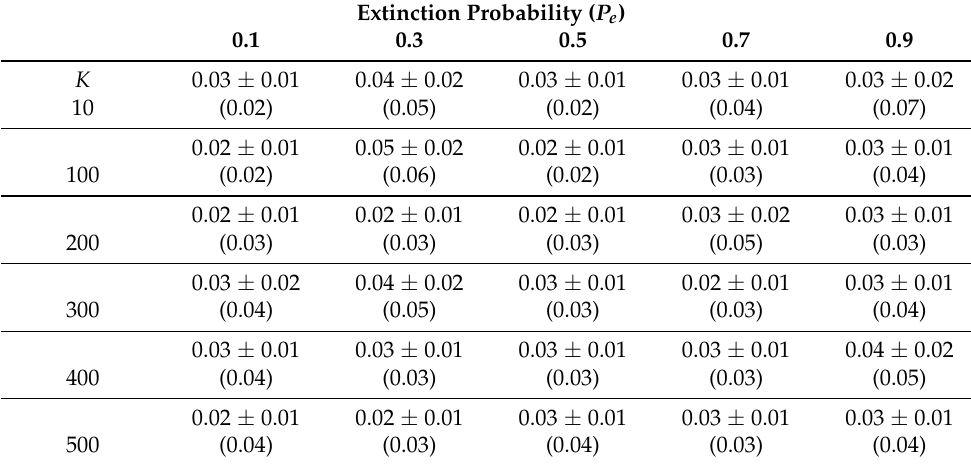
Table 5. Fitness results of SDEP with random extinction on Griewank ( K is the stagnant counter); 95% confidence interval is presented after ± sign, and standard deviation is presented inside